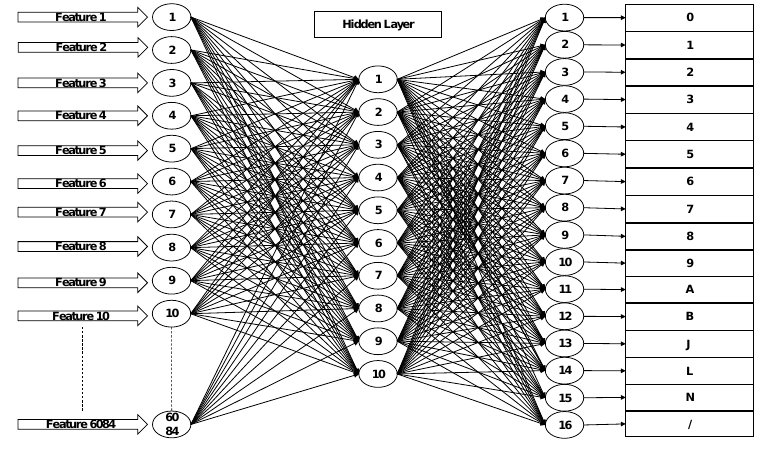
Figure 7. Artificial neural network architecture.